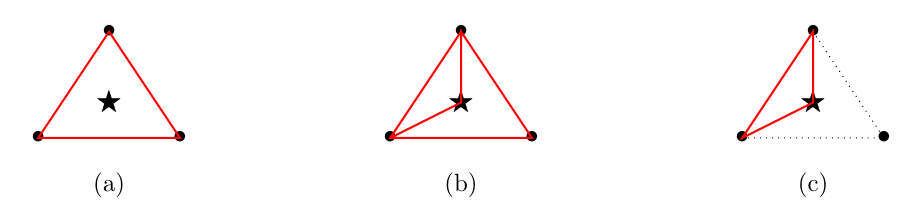
Figure 4. One-parameter family of solutions interpolating between the maximal Higgs solution (a) and the connected con(cid:12)guration (c) between D and C [ (cid:22) ]. The intermediate states (b) have di(cid:11)erent magnitudes for the (cid:12)elds